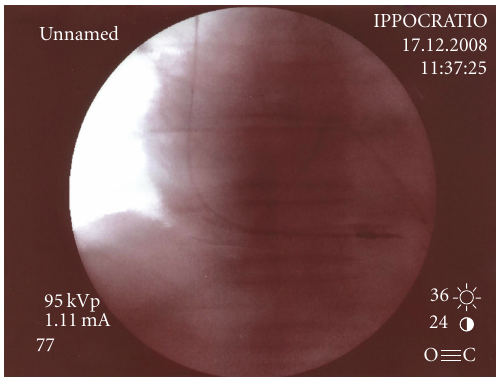
Figure 2: The guide wire is advanced through the left subclavian vein to the right atrium, but with a loop because of significant tortuosity of the superior vena cava.